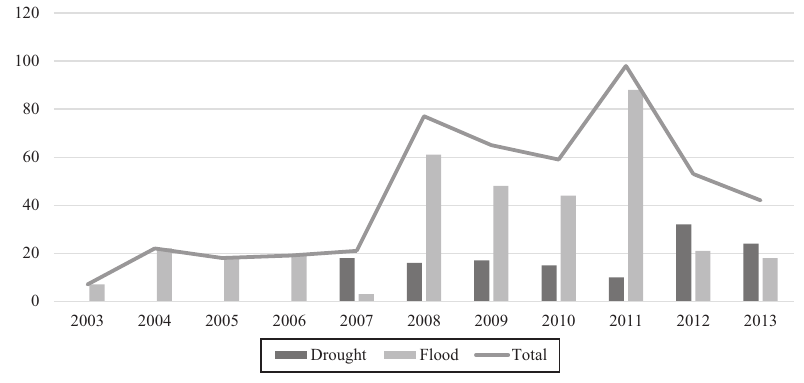
Figure 3. Distribution of